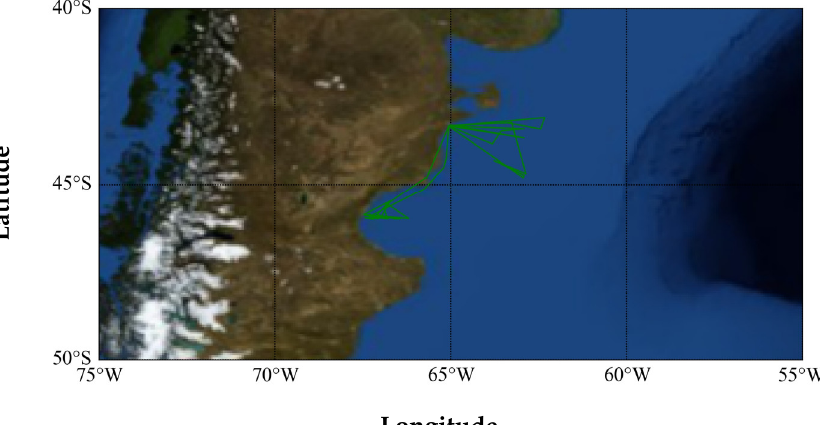
Figure 7. The registration information and photos of the ship (MMSI: 367588710) on the Marine Traffic website.